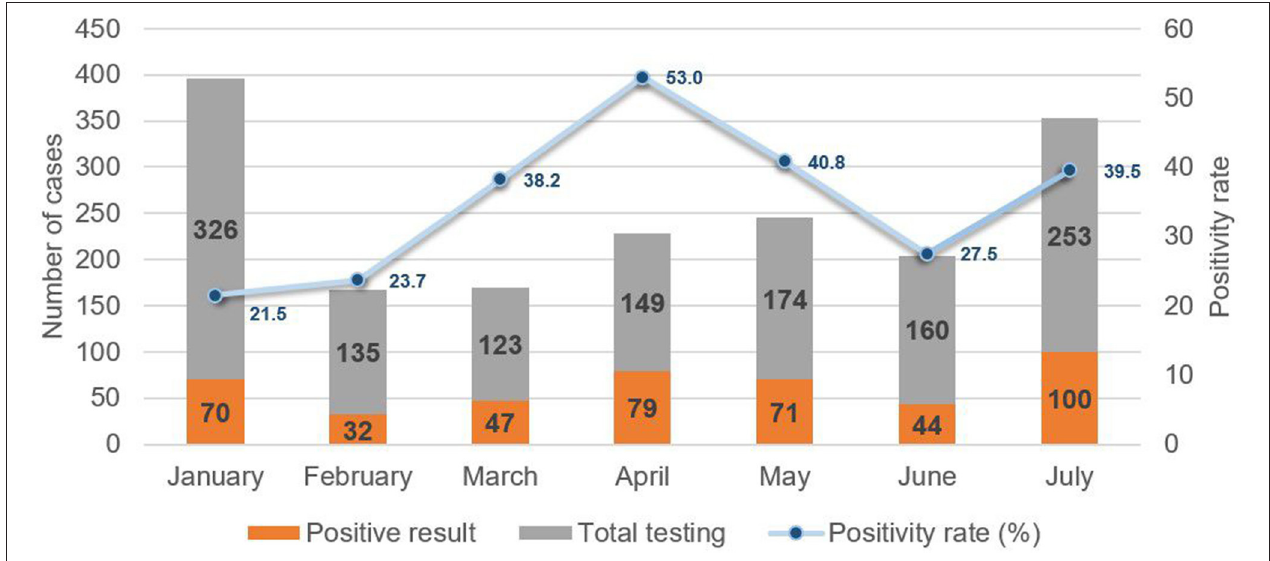
FIGURE 5 | New pediatric COVID-19 cases and positivity rate from January to July 2021 at Murni Teguh Memorial Hospital.